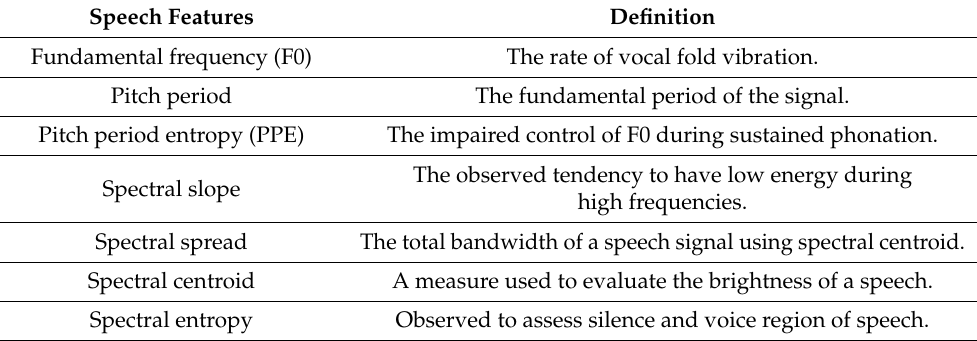
Table 1. Summary of common speech features indicative of